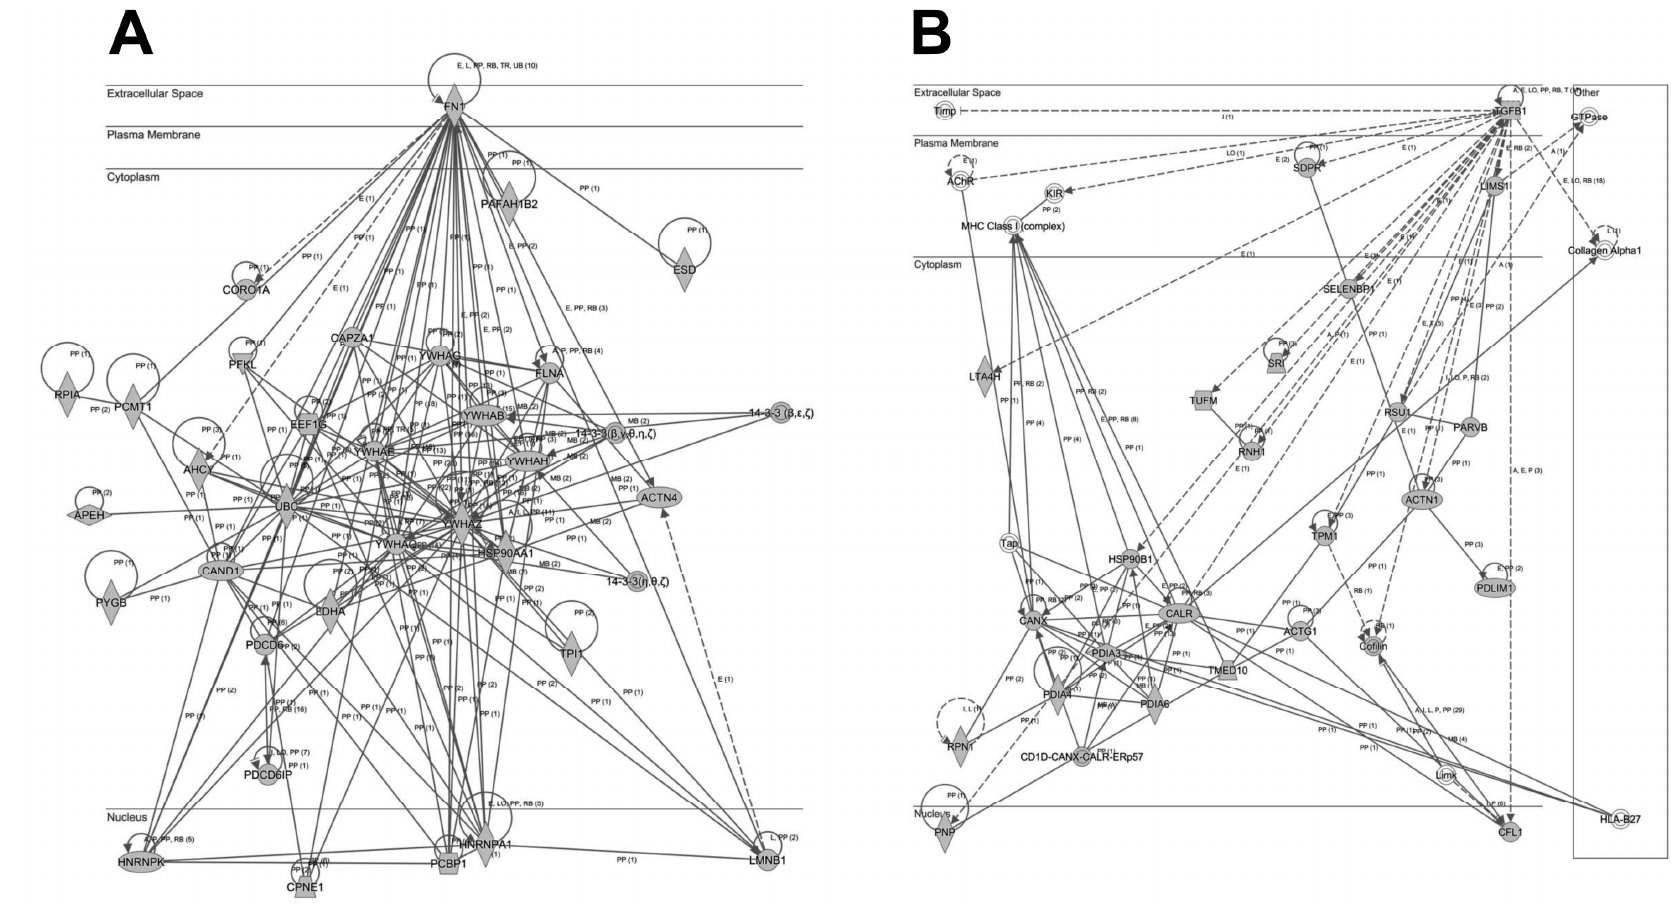
Figure 5. Representation of the relationships between thrombotic proteins characterized in this study: fibronectin 1 and 14-3-3 family proteins ( A ) and TGF β signaling ( B ). Continuous lines represent direct interactions, whereas discontinuous lines correspond to indirect interactions. The complete legend may be found at http://ingenuity.force.com/ipa/articles/Feature_Description/Legend.